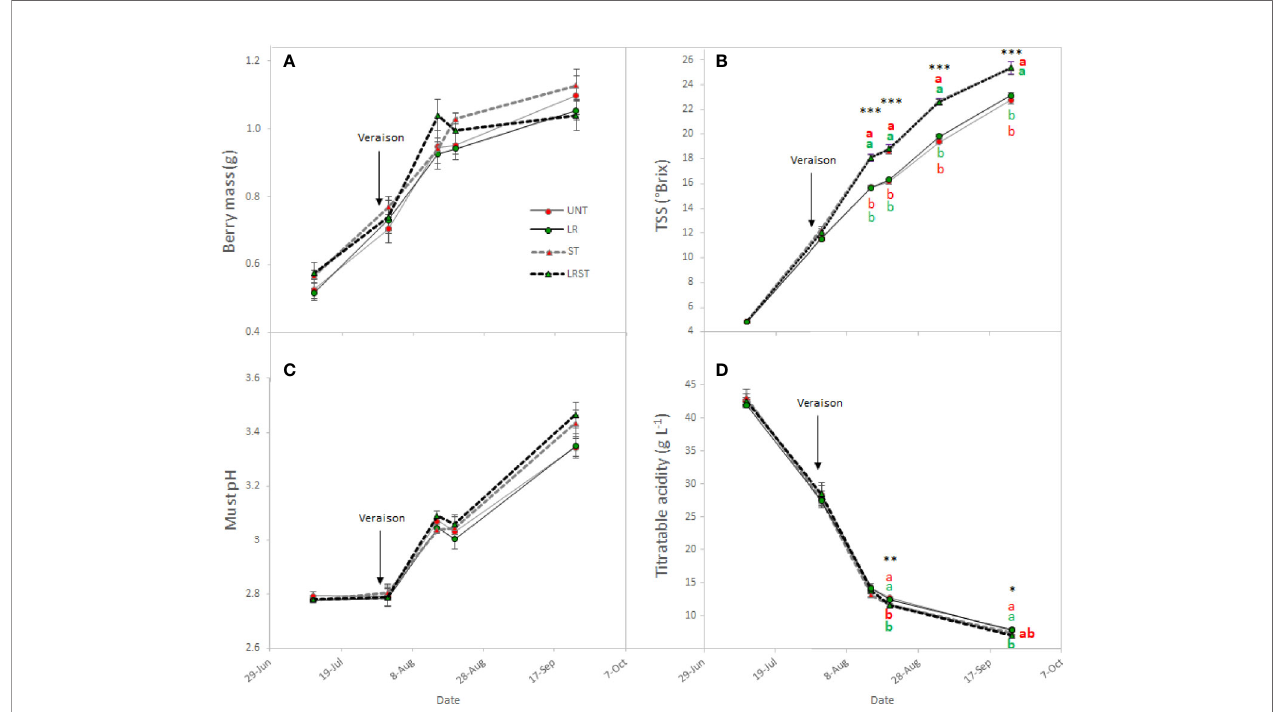
FIGURE 3 | Effect of canopy management practices (UNT, untreated; LR, leaf removal; ST, shoot thinning and LRST, LR and ST combined) on berry mass (A) Brix (B) , must pH (C) , and titratable acidity (D) the growing season. Values represent means ± SE (n = 4). At each time point, different letters indicate signi fi cant differences ( p < 0.05) between canopy management practices according to the one-way ANOVA followed by Duncan's new multiple range test. *, **, and *** indicate signi fi cance at 5%, 1%, and 0.1% probability levels,